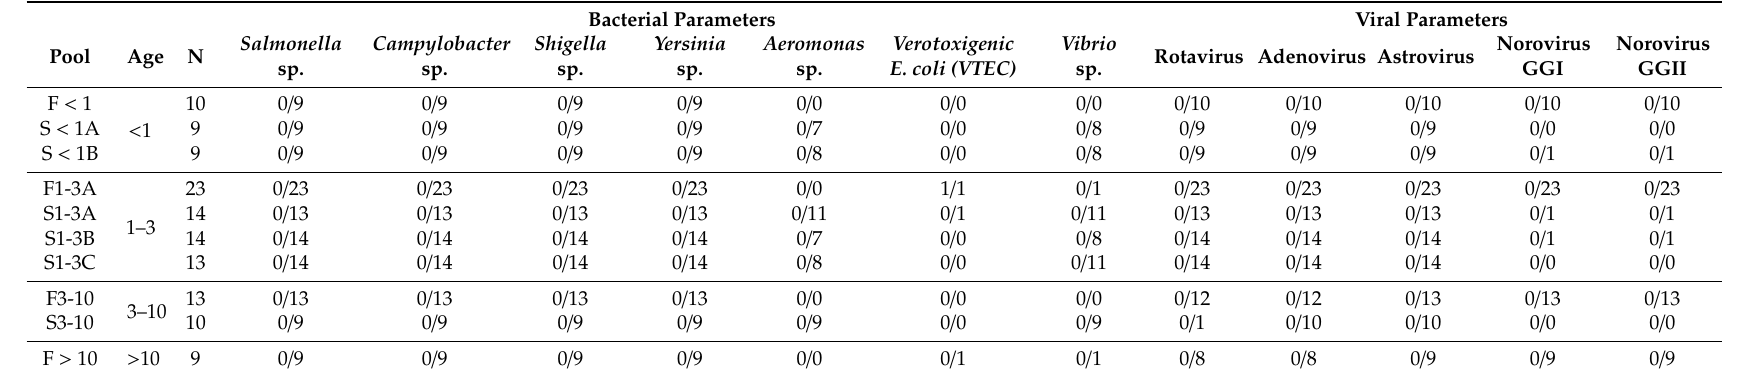
Table 1. Summary of the samples composing each sequenced pool according to age criteria and the performed conventional diagnostic assays in the clinical center. The results of the bacterial and viral parameters are expressed as the “number positive samples / number samples tested”. For human adenovirus, human rotavirus and human astrovirus, a commercially available immunochromatographic test was employed (ONE STEP Adenovirus CARD TEST, ONE STEP Rotavirus CARD TEST and ONE STEP Astrovirus CARD TEST, Certest Biotec S.L). For norovirus GI and GII, conventional RT-PCR was used